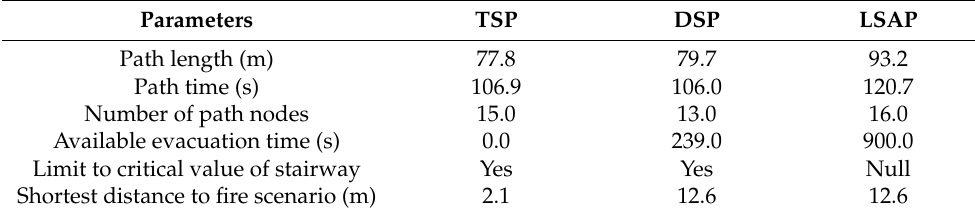
Table 12. Comparative analysis of the parameters of different evacuation passageways in